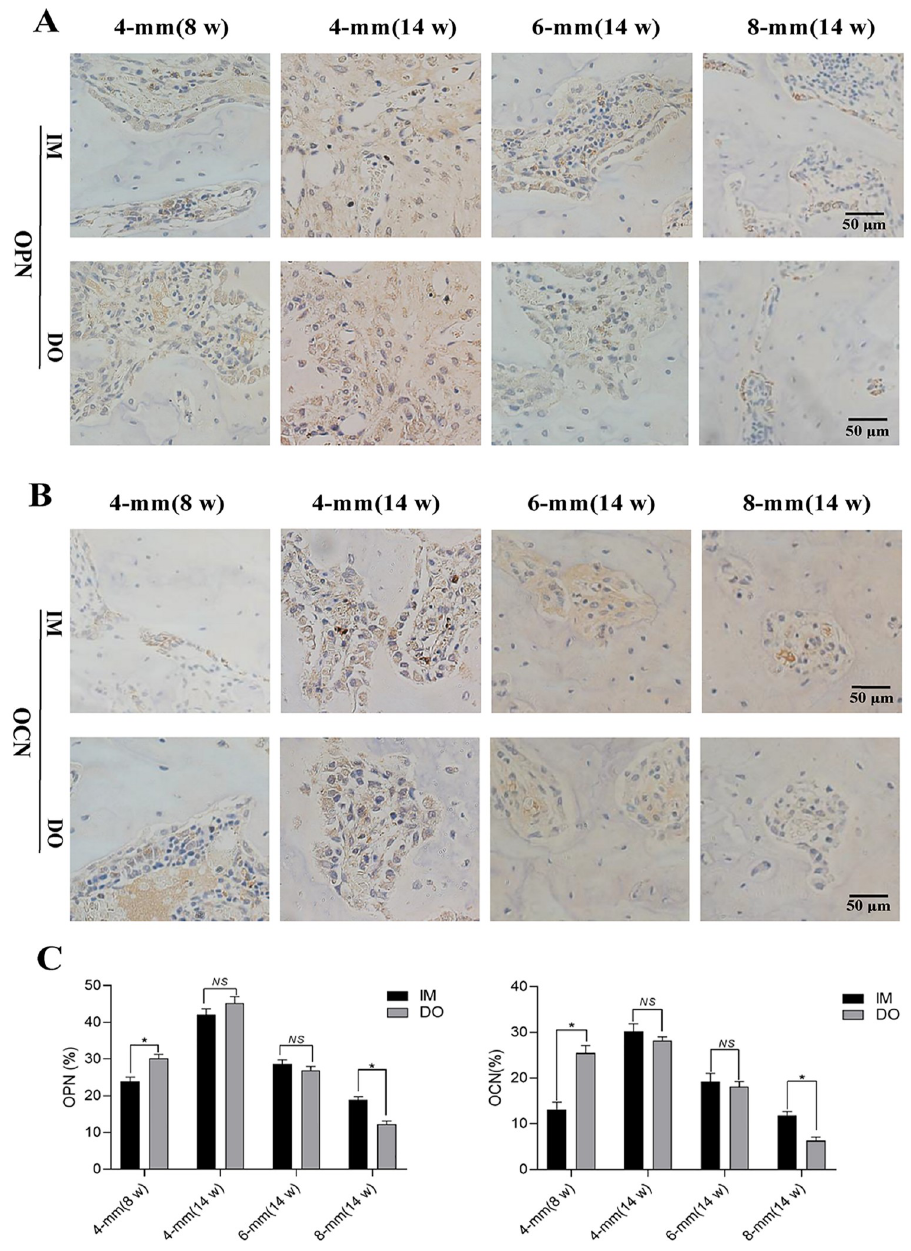
Fig 6. Immunohistochemical of OPN and OCN in newly-formed tissues within the defect regions of 4-, 6- and 8-mm groups. (A)-(B) Representative images of immunohistochemical results of OPN and OCN and (C) quantitative analysis of the positive cells in the bone defect regions. ( � P <